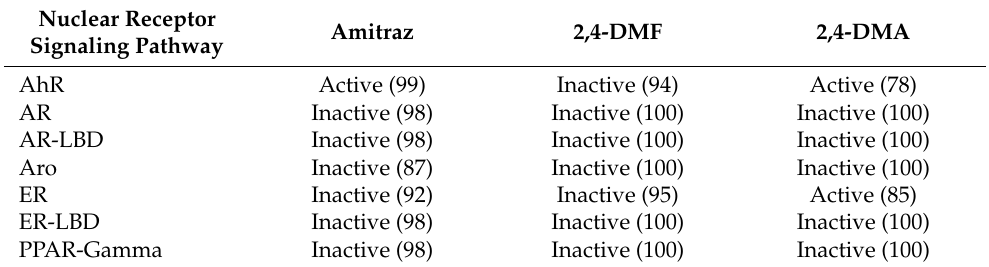
Table 3. Prediction of Tox21-nuclear receptor signaling pathways of amitraz and its metabolites. Nuclear Receptor